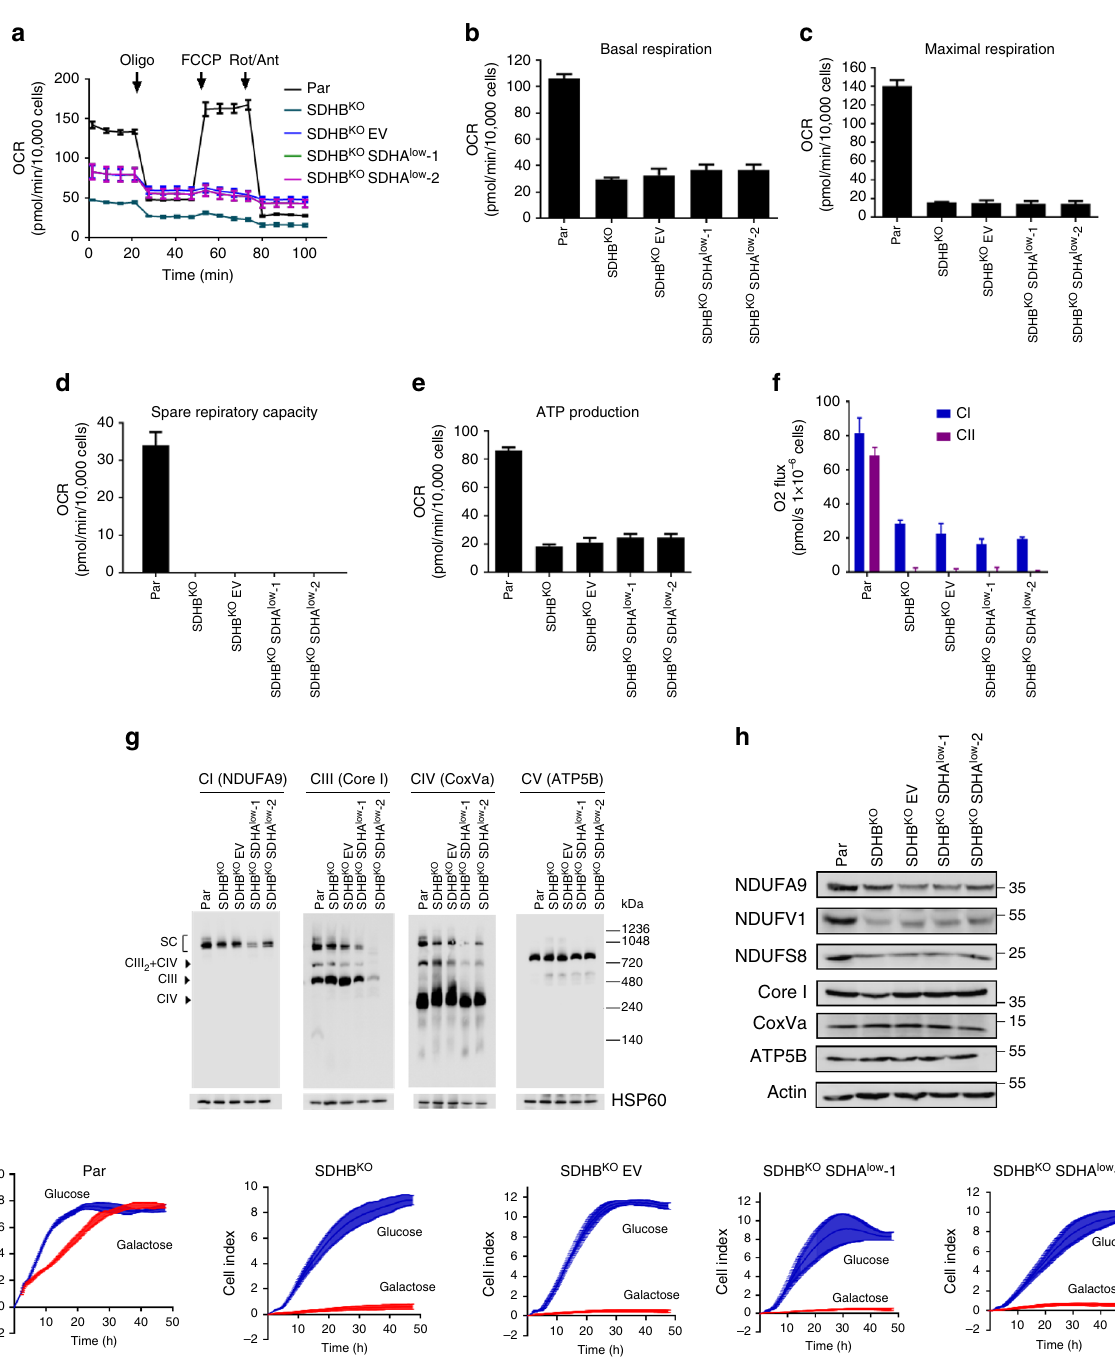
Fig. 3 CII low does not regulate mitochondial bioenergetics. a Oxygen consumption rate (OCR) in MDA231 sublines was followed during sequential additions of oligomycin, FCCP, and combination with rotenone and antimycin. b – e Basal respiration, maximal respiration, spare respiratory capacity, and ATP production. f CI- and CII-dependent respiration was evaluated in permeabilized cells using the Oxygraph. g Mitochondria isolated from MDA231 sublines were subjected to NBGE followed by WB analysis using antibodies against NDUFA9, NDUFV1, NDUFS8 (CI), Core I (CIII), and COXVa (CIV) and ATP5B (CV). h MDA231 sublines were analyzed for subunits of OXOPHOS complexes using WB after SDS-PAGE. i MDA231 sublines grown in media containing either glucose or galactose were evaluated for proliferation using the xCELLingence instrument. Data shown are mean values± SD ( n = 3); images and graphs in i are representative of three independent